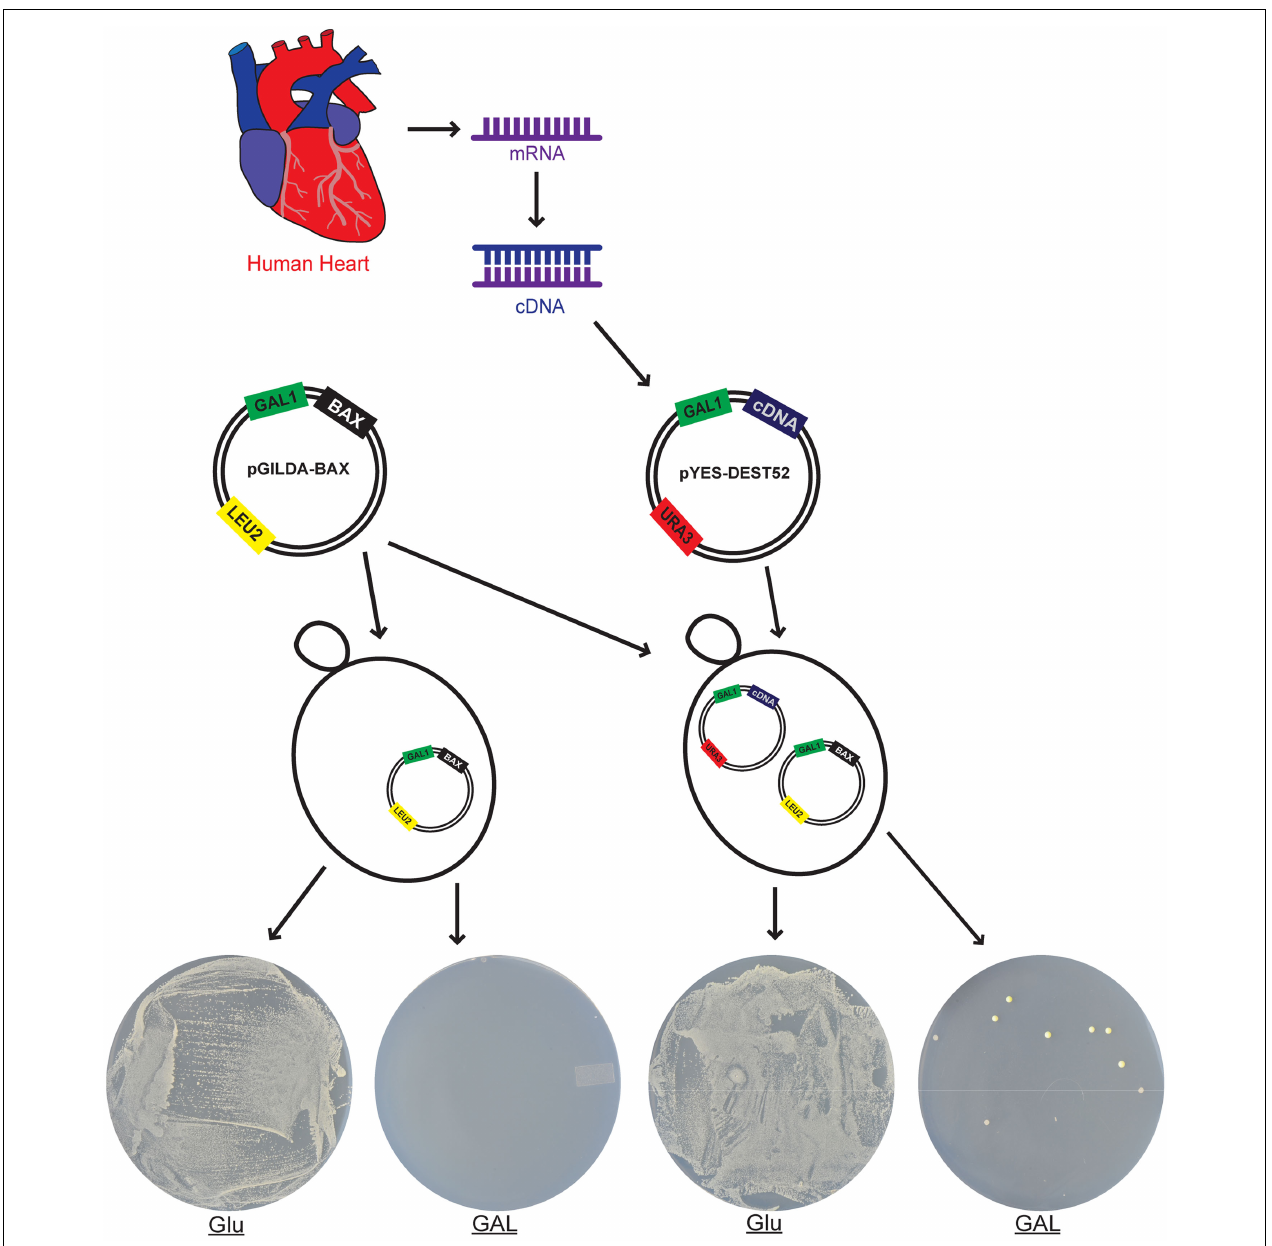
grown on glucose media but undergo cell death due to the expression of Bax when grown on galactose media. Close to 10 6 yeast transformants harboring both pGILDA-Bax as well as different cDNAs from the pYES-DEST52 cardiac cDNA library were grown on galactose media. A total of 72 different colonies containing over 60 different putative Bax suppressors were identified when the pYES-DEST52 cardiac cDNAs were isolated and their nucleotide sequence determined (Yang et al., 2006). Similar apoptotic resistant phenotypes can be achieved in the heart by subjecting the tissue to a period of mild stress in order to induce pre-conditioning. Glu, glucose; GAL,